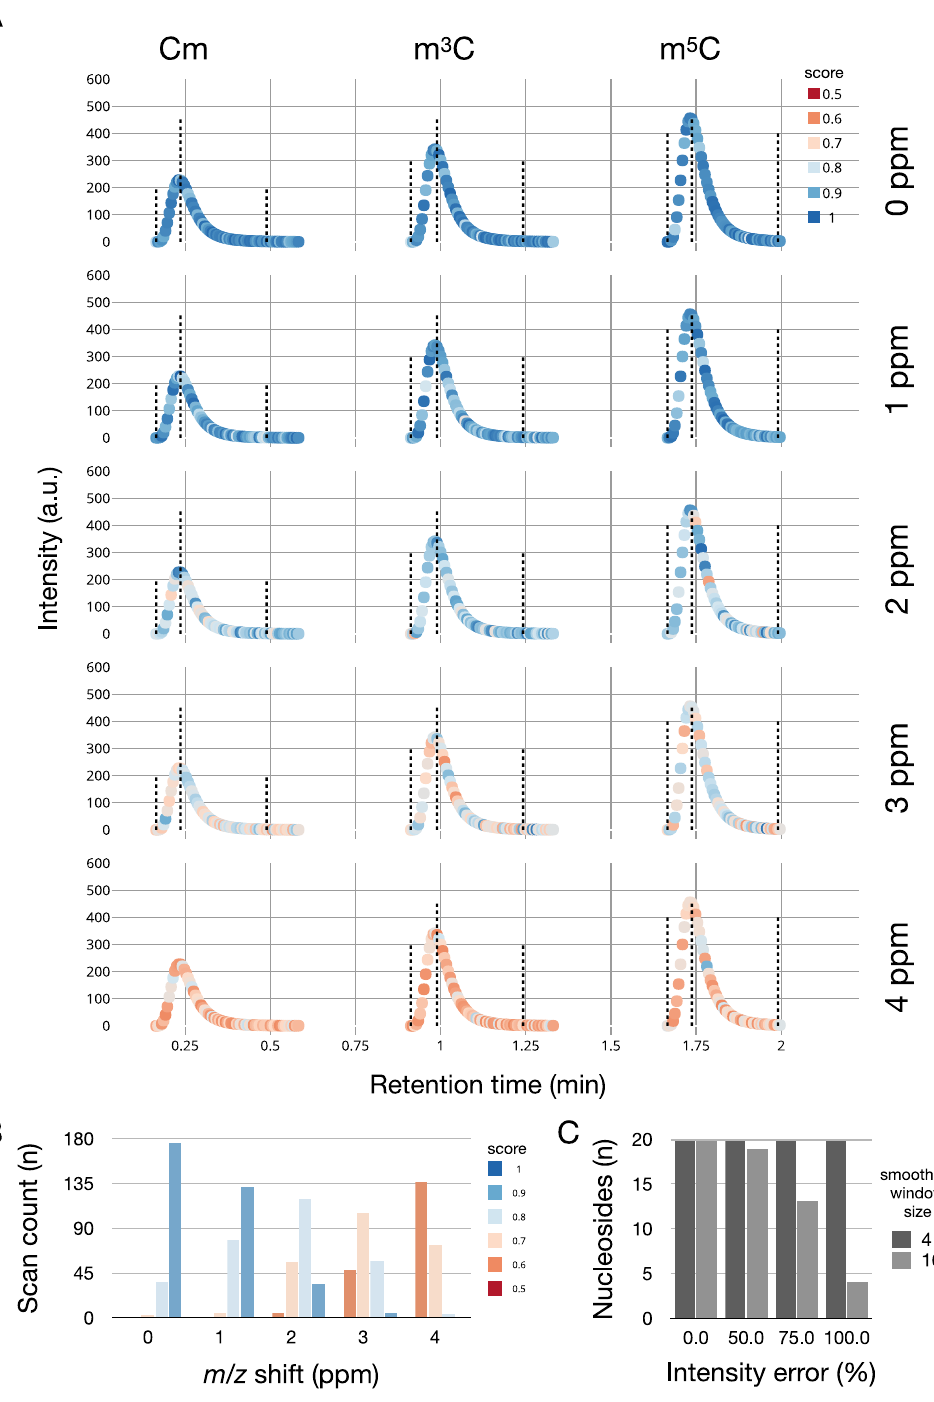
Figure 5. ( A ) Simulation of different ppm errors for the three nucleosides 2 (cid:48) - O -methylcytidine (Cm), 3-methylcytidine (m 3 C), and 5-methylcytidine m 5 C. Absolute intensities are plotted on the Y-axis, retention time on the x-axis. The quality of the mass spectrum is indicated by color: dark blue (high quality), dark red (low quality). The dotted lines indicate the start of the peak, the peak apex, and the end of the peak (from left to right). ( B ) Number of spectra with a pyQms-quantification score for all methylated cytidines above a certain threshold, dependent on the introduced m / z shift error in ppm. ( C ) Number of detected nucleosides dependent on the introduced intensity error. Values are shown before (smoothing window size = 16, light grey) and after (smoothing window size = 4, dark grey) parameter